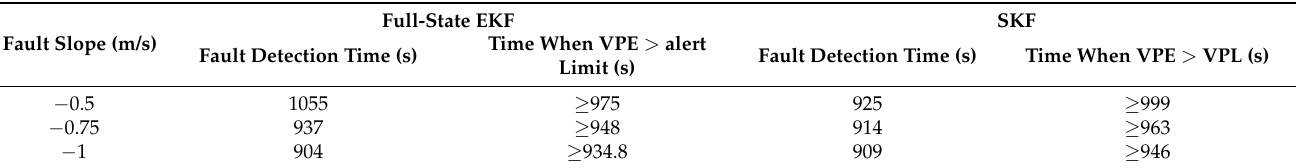
Table 3. Ramp fault detection performance of full-state EKF and SKF with different slopes. Time is noted from the beginning of